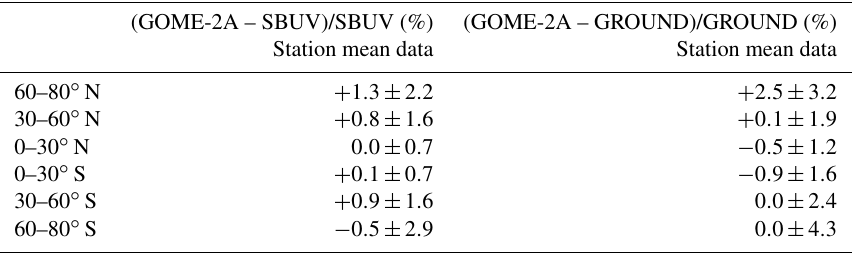
Table 1. Mean differences and their standard deviations in percent between total ozone from GOME-2A, SBUV (v8.6) satellite overpass data, and ground-based observations over different latitude zones, as shown in Figs. 1 and 2.